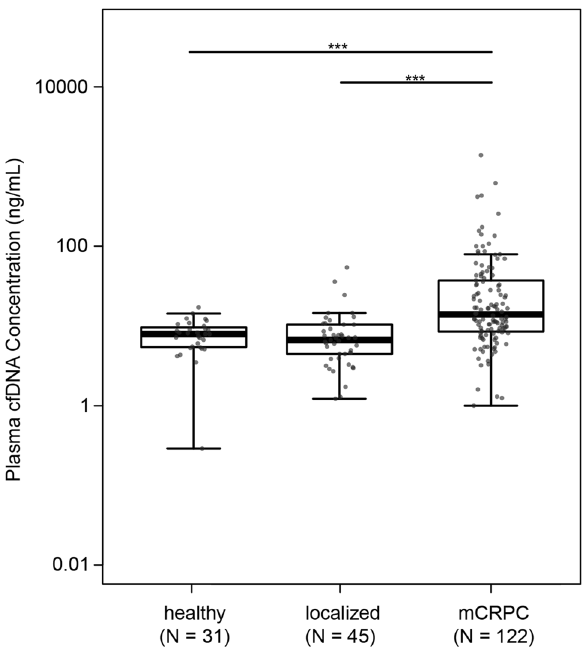
Figure 1. Distribution of plasma cfDNA concentration in healthy individuals, patients with localized disease, and patients with mCRPC. Boxplots and points identify the minimum, interquartile range, median, and maximum values for each group. The Mann–Whitney test was applied to test differences in cfDNA concentration between groups. *** P <